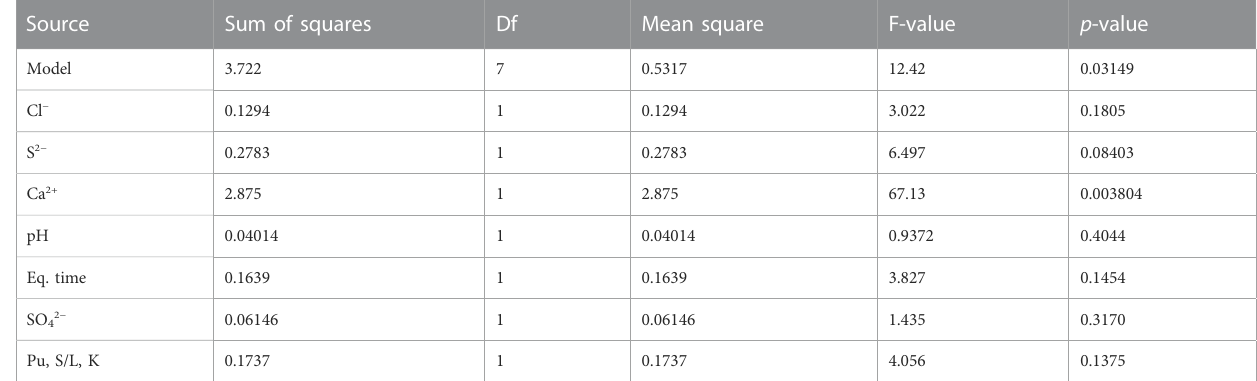
TABLE 6 ANOVA table of the screening experiments for log R d .